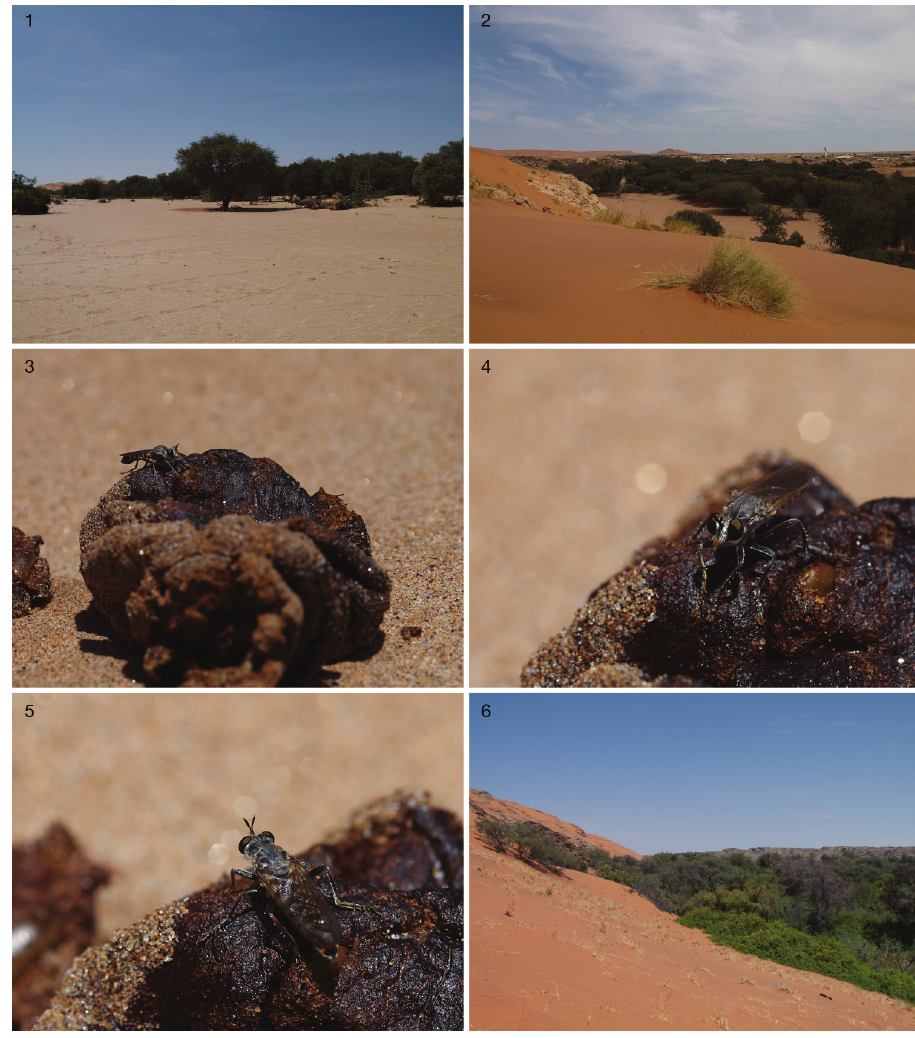
Figures 1–6. Habitats and photographs of Laphyctis eremia sp. n.: 1 dry Kuiseb riverbed at Gobabeb, Namib Desert, Namibia (23°33'35"S, 015°02'06"E) 2 view south over dry Kuiseb riverbed and Gobabeb Research & Training Centre from high dune 3–5 ♂ perching on dung in dry Kuiseb riverbed as shown in 1 (Morphbank #861457, 861459, 861461) 6 slope of high dunes at Homeb, Namib Desert, Namibia (23°38'34"S, 015°10'55"E) where L. eremia sp. n. was collected on the